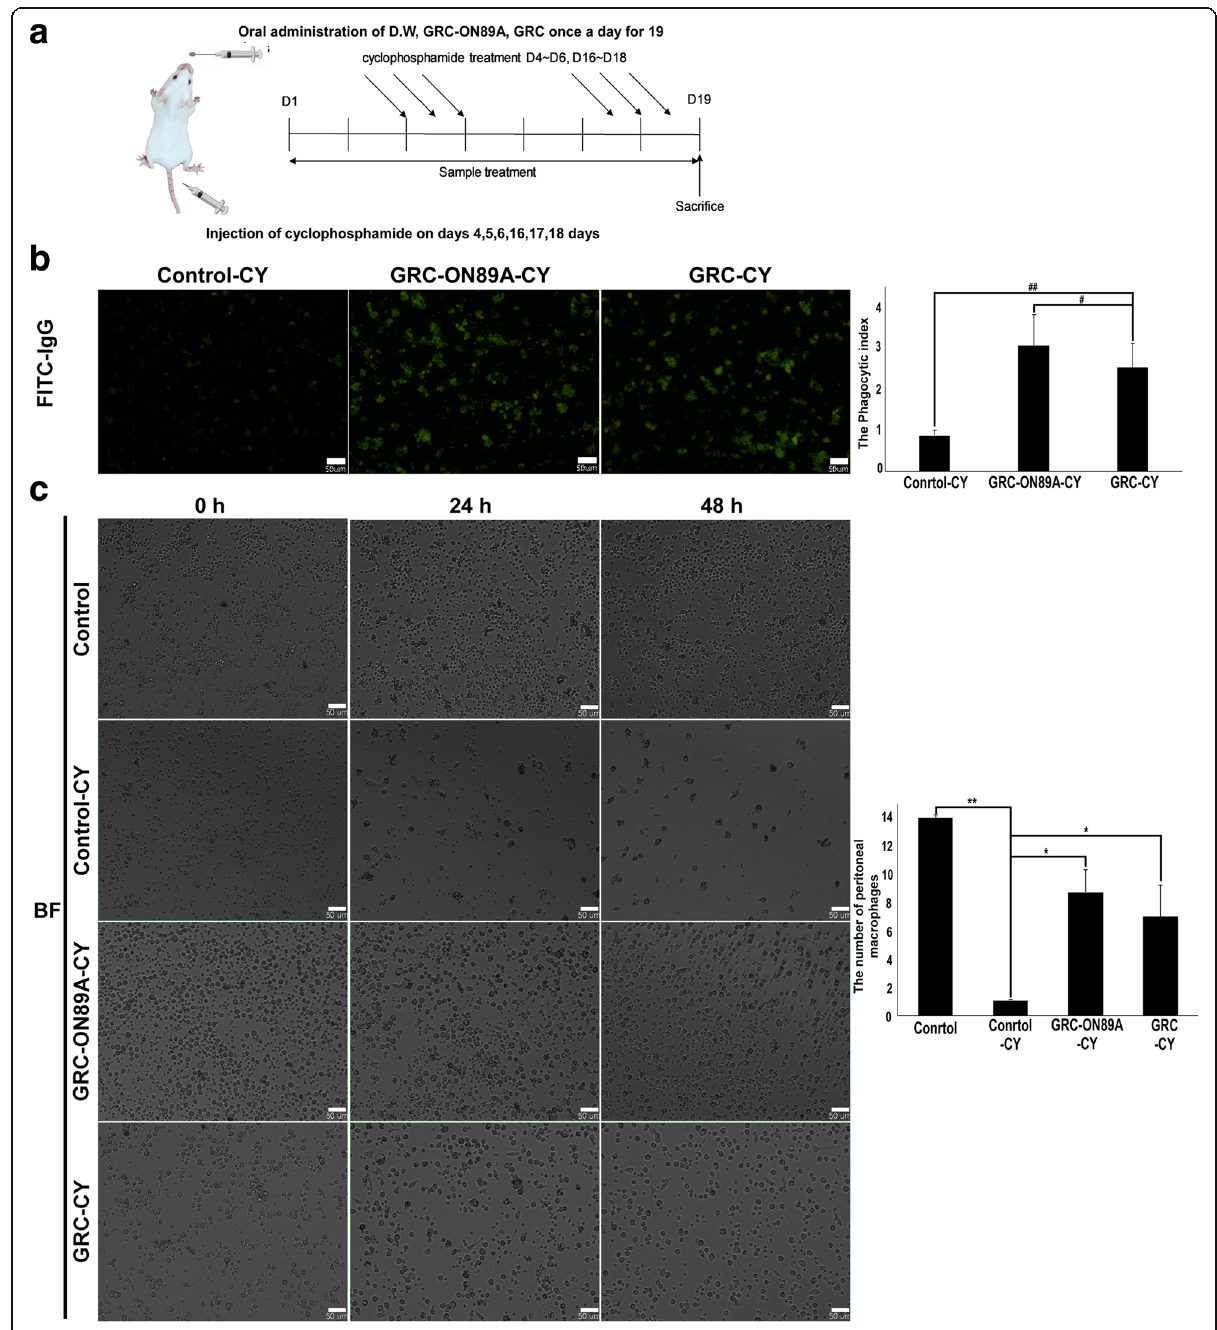
Fig. 3 Effects of GRC-ON89A on the phagocytic activity of peritoneal macrophages in CY-treated mice. a Scheme summarizing the immunosuppressed murine model protocol. b Fluorescent microscopy images (left panel) of phagocytosis of primary peritoneal macrophages from CY-treated immunosuppressed groups. Cells (5 × 10 4 cells per well) were treated with DMSO vehicle (100 μ g/mL GRC and 100 μ g/mL GRC-ON89A). Quantification of fluorescent bead uptake by primary peritoneal macrophages from CY-treated immunosup- pressed groups exposure to fluorescent beads for 24 h (right panel). One-way ANOVA was used for comparison of group means, followed by Dunnett ’ s t -test (## = p < 0.01, # = p < 0.05 vs GRC-CY group). c Effect of GRC-ON89A on primary peritoneal macrophage proliferation. The cell image (left panel) of primary peritoneal macrophages from CY-treated immunosuppressed model group after oral administration (D.W., 1% GRC and 1% GRC-ON89A). The cell proliferation rate was quantified for statistics analysis using Image J software (right panel). One-way ANOVA was used for comparison of group means, followed by Dunnett ’ s t -test (** = p < 0.01, * = p < 0.05 vs control-CY group). Each figure is representative of three independent experiments; Scale bars = 50 μ